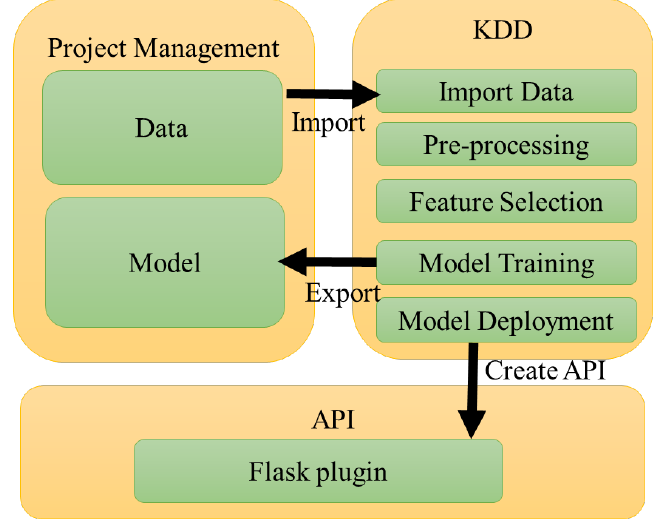
Figure 10. PdM analytics on the cloud.